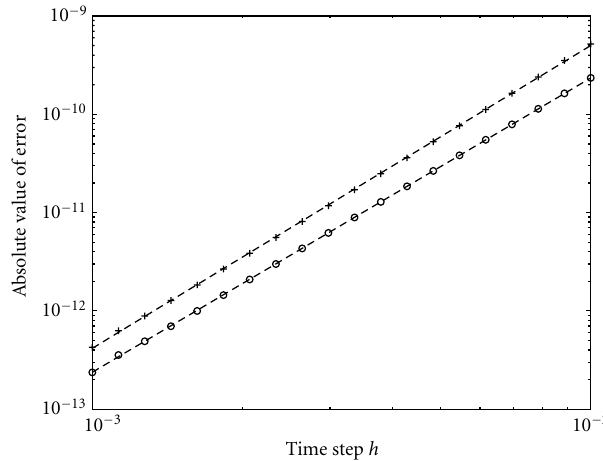
Figure 3.4. Absolute value of error at t = 10 in solution of (3.2) versus step size. The pluses show results for the accelerated RK3 scheme using the parameters given in (2.9b) and the circles show the standard